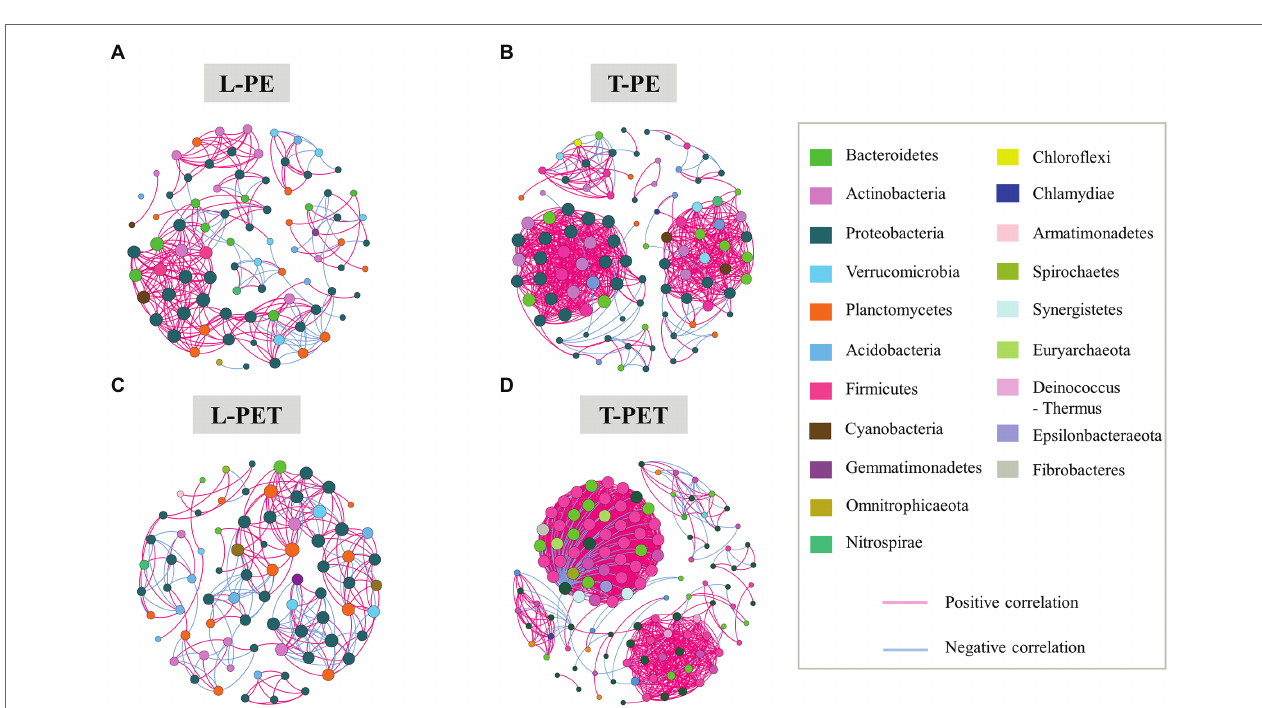
FIGURE 4 | The cladogram of biofilm bacterial clusters with significant dissimilarities ( p < 0.05) between lake and tap water samples on PE (A) and PET (B) materials using linear discriminant analysis (LDA) effect size (LEfSe) analysis. The green and red regions (including circles) represent the respective biofilm bacterial clusters originating from tap and lake water, and the yellow circles represent bacterial clusters without significant dissimilarities. Each chart inside out represents biofilm bacterial taxonomies from phylum to genus levels. Bacterial clusters with ≥ 4 of LDA values are labeled.